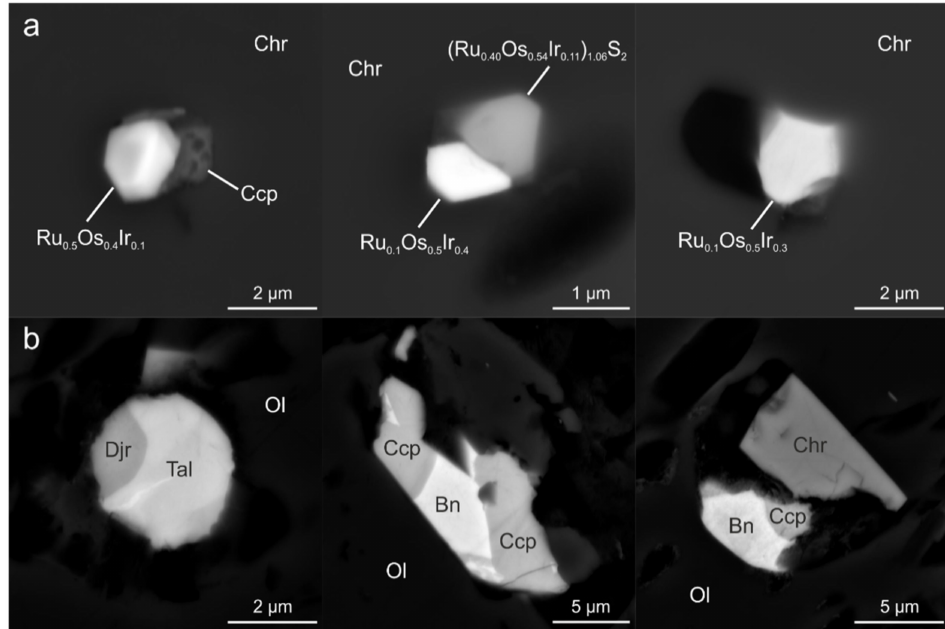
Figure 4. Backscattered-Electron (BSE) photographs of the platinum-group metals (PGM) ( a ) and sulfides ( b ) in dunites. Ccp—chalcopyrite; Chr—chromite; Ol—olivine; Djr—djerfisherite (K 6 (Fe;Cu;Ni) 25 S 26 Cl); Tal—talnakhite (Cu 9 (Fe;Ni) 8 S 16 ); Bn—bornite (Cu 5 FeS 4